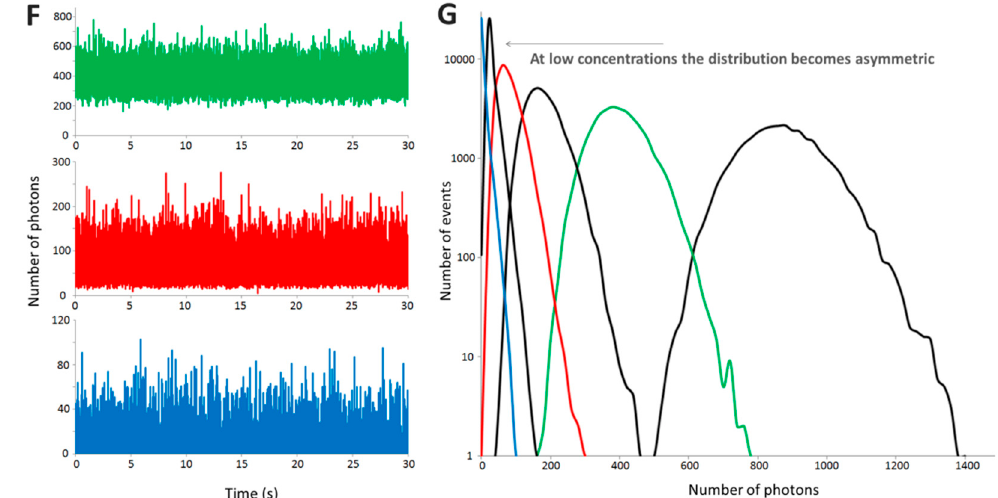
Figure 2. From photon counting histograms to brightness analysis: ( A , B ) Typical time traces of fluorescence obtained in “pure” single-molecule experiments for GFP ( A ) and GFP-foldon (foldon is an artificial trimerization domain) ( B ) The number of photons detected is often referred to as “counts per millisecond” (cpms); ( C ) Photon Counting Histograms obtained for 5 distinct experiments for each protein, the colors indicate the different repeats. The GFP curves converge to a maximal value of 80 photons per ms whereas the GFP-foldon proteins reaches a maximum of 250 photons per ms; ( D ) A simulated GFP trimer photon counting histogram obtained by multiplying a monomer trace by three and analyzed for the distribution of values; the data show that the slope of the distribution matches with that of the experiments; ( E ) As concentration of the sample increases from 100 pM to 10 nM, the average number of molecules in the confocal volume increases from <1 to 10 molecules/ms. A typical focal volume is 200–300 nanometers in width and 2–6 times larger in the vertical axis; ( F ) The increase of the average number of molecules is reflected by the increase in background of a typical fluorescent time traces obtained for different concentrations of GFP; ( G ) The distribution of number of events changes from asymmetric at low concentrations to a Gaussian profile. The colors correspond to the time traces in ( F ); intermediate concentrations are shown in black.